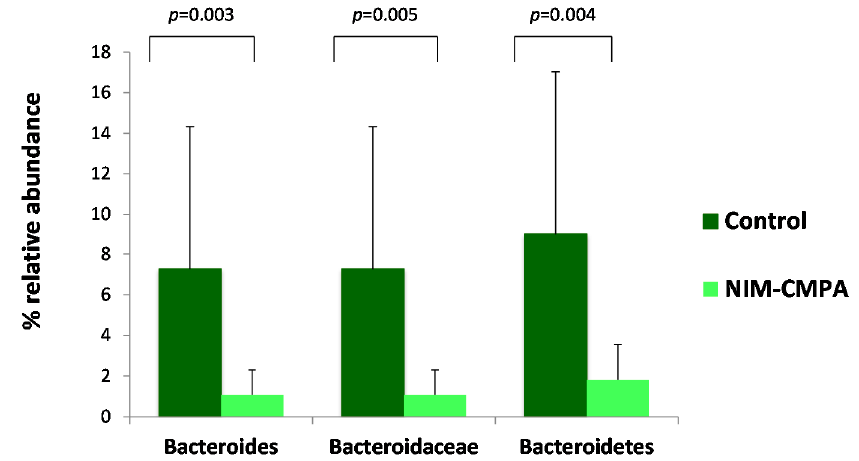
Figure 2. Differences in relative abundances (%) of sequences belonging to the phylum Bacteriodetes, the family Bacteroidaceae , and the genus Bacteroides in fecal samples of infants with non-IgE mediated cow’s milk protein allergy (NIM-CMPA) ( n = 17) and non-allergic control infants ( n = 10). Comparisons were corrected with a false discovery rate (FDR) of